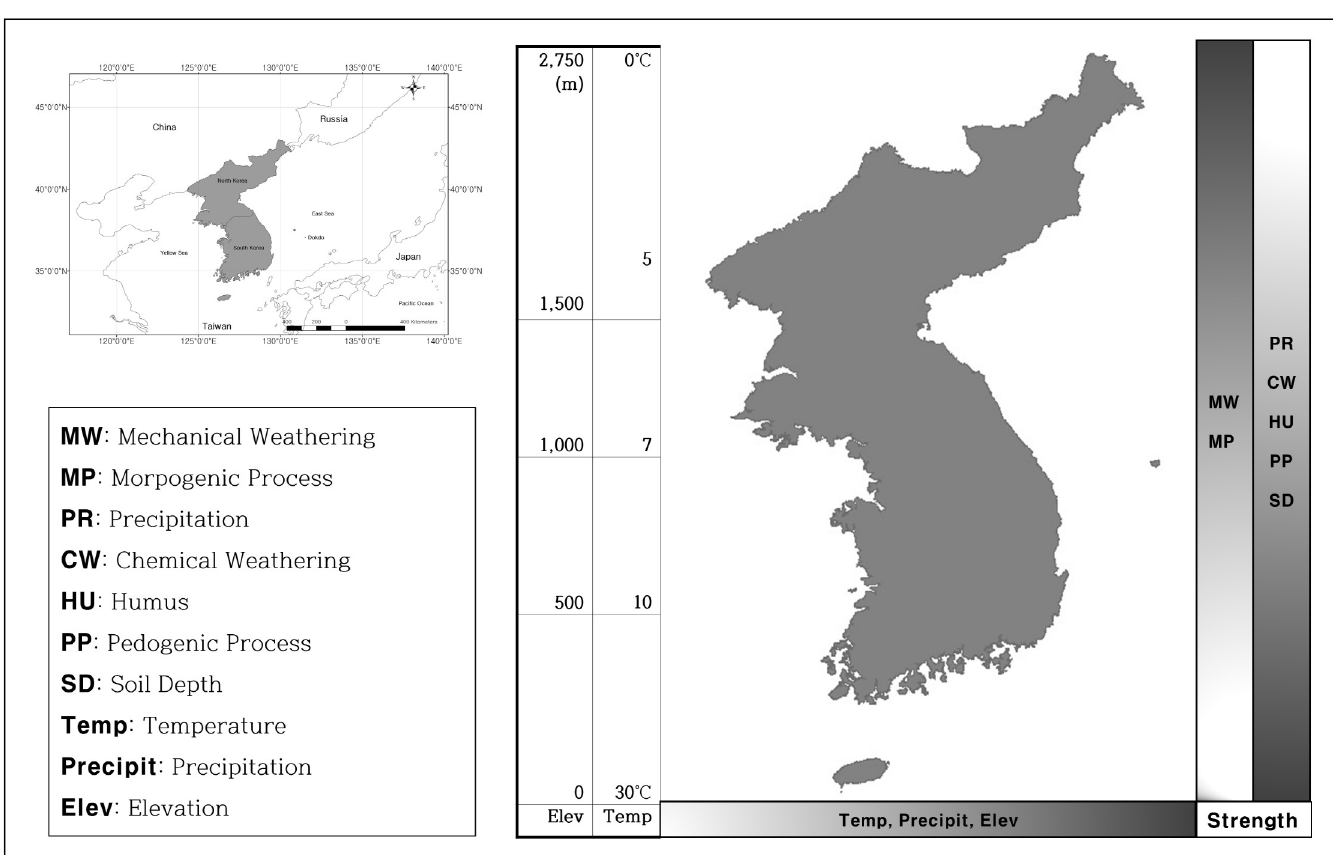
Fig 1. Diagram of geomorphic milieu in Korean Peninsula (base map data source: Https://gadm.org/).